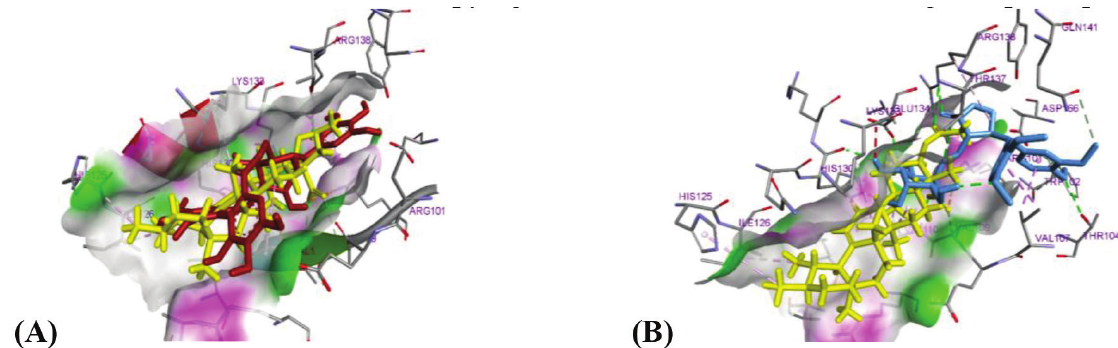
Figure 5. 3D visualization of the native AKBA ligand compatible conformation (yellow molecule) with ( A ) gallotannin (red mol- ecule) and ( B ) urticin А (blue molecule).